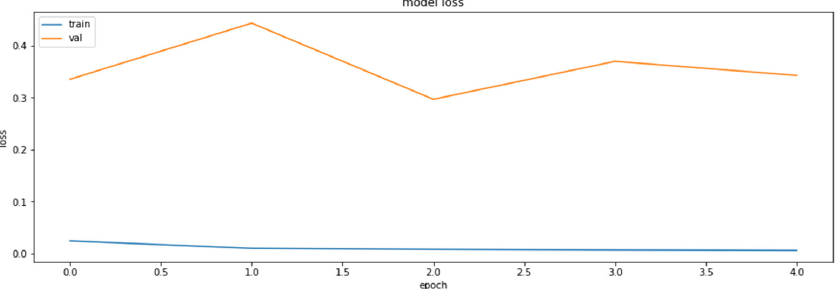
Figure A2. The accuracy of the model for the training and the validation dataset obtained during the training of the model with the weights clustered with KMeans++ initialization of 32 centroids. The centroid initialization algorithm: Linear The number of the clusters: 32